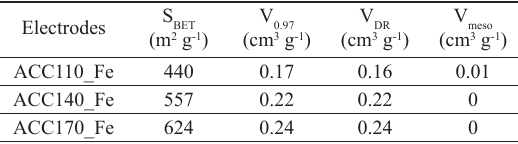
Table 1. Textural properties of carbon